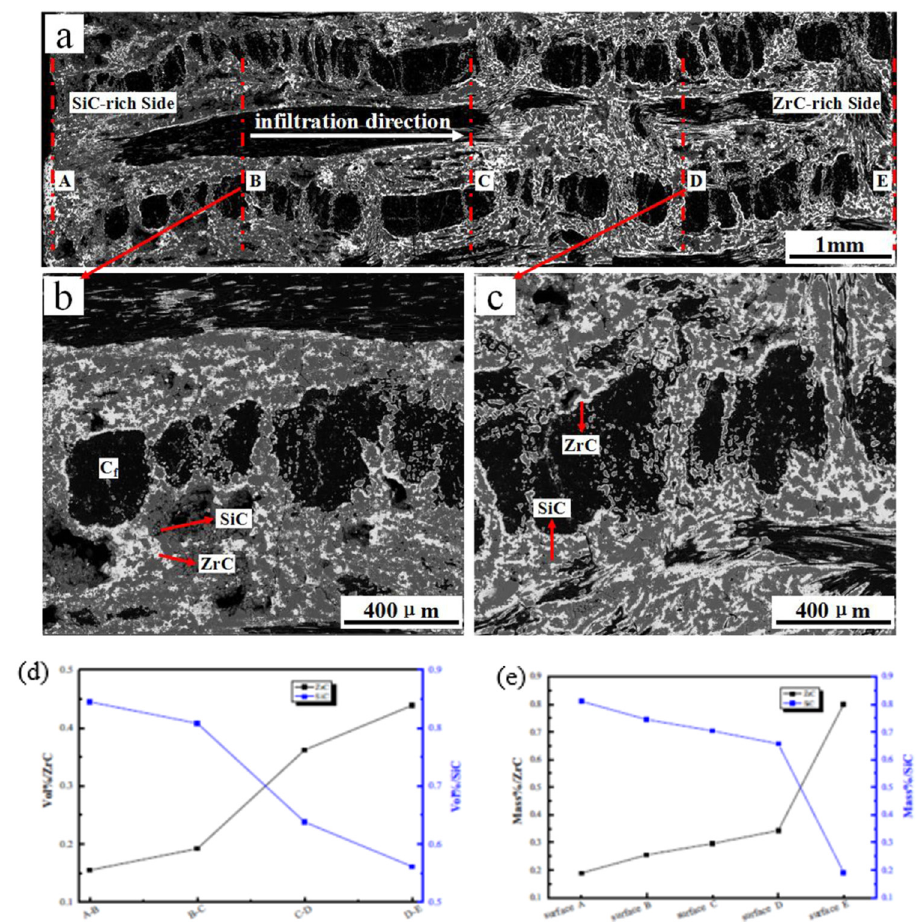
Figure 4: SEM images of the cross - section of C/C – ZrC – SiC [ 63 ] : ( a ) whole cross - section, ( b ) magni fi cation of point B, ( c ) magni fi cation of point D, ( d ) volume percentage of ZrC and SiC of four areas in ( a ) , and ( e ) mass percentage of ZrC and SiC calculated based on XRD